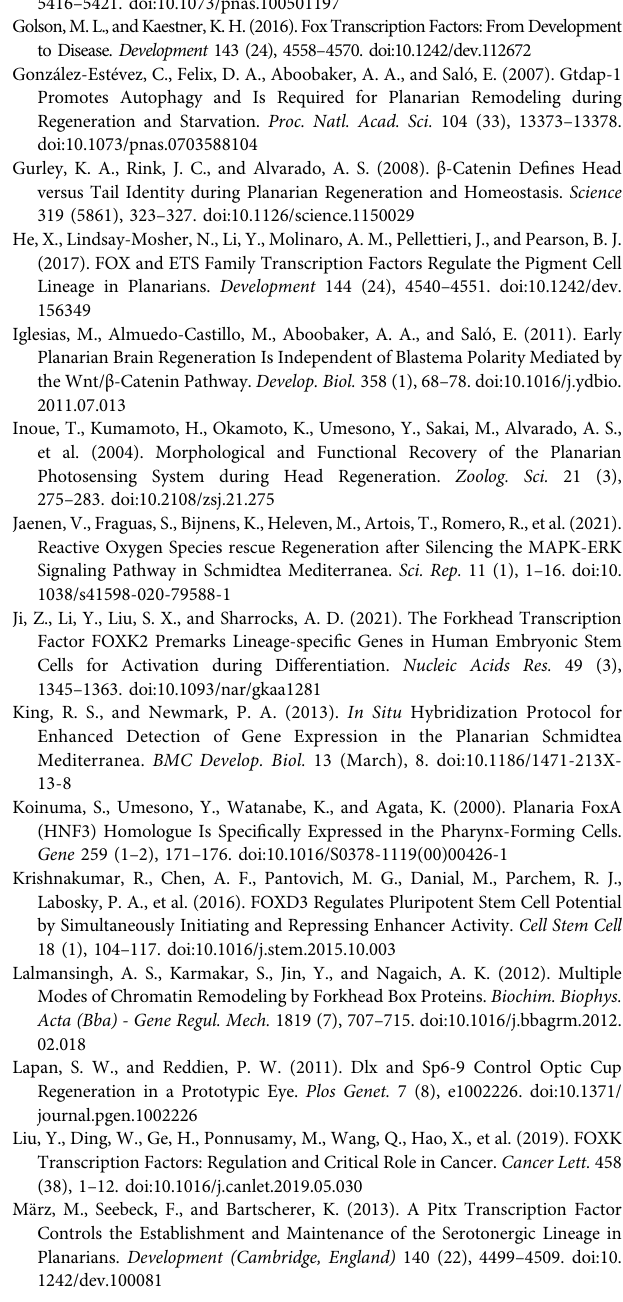
(Cowles et al., 2013) reveals a decreased number of sim-expressing cells all along the planarian body of foxK1 silenced planarians. Animals at 7 days of regeneration are shown. Scale bar: 100 µm. (B) Whole-mount in situ hybridization of innexin10 (Nogi and Levin 2005) labeling the planarian excretory system reveals correct regeneration of excretory cells in foxK1 silenced planarians. Animals at 7 days of regenerationareshown.Scalebar:100 µm. (C) Whole-mountinsituhybridizationof the gut marker pk (Fraguas et al., 2014) showing that treated planarians regenerate correctlythegut.Whole-mountimmunostainingagainst α